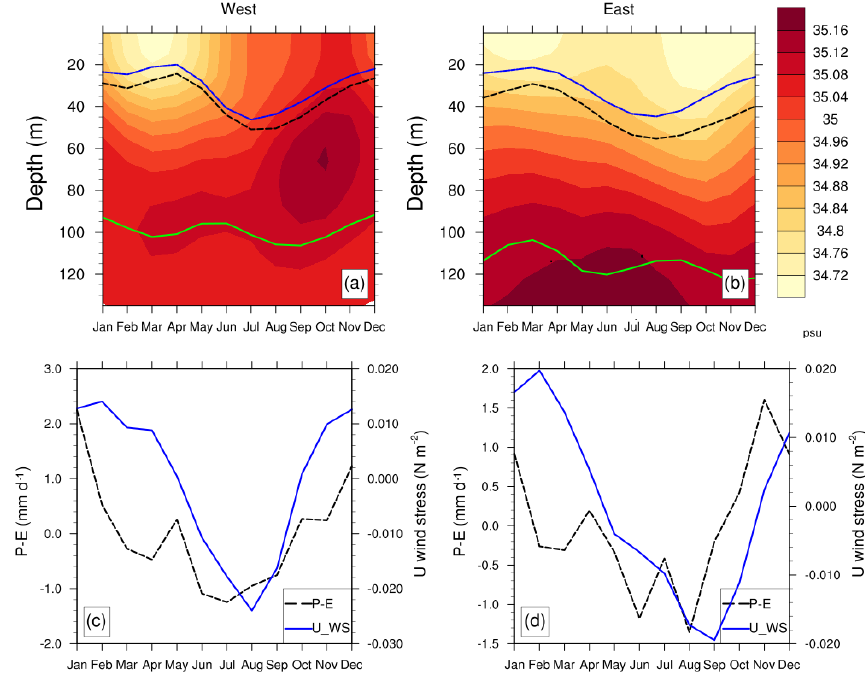
Figure 8. Seasonal variation in the western TIO (12 ◦ S–5 ◦ N, 55–75 ◦ E) (a, c) and the eastern TIO (12 ◦ S–5 ◦ N, 85–100 ◦ E) (b, d) . The top figures show the depth–time plots of the upper-ocean salinity (shaded), the thermocline depth (green line), isothermal layer (dashed black line), and mixed layer (blue line). The bottom figures show the freshwater flux ( P − E ) and zonal component of the wind stress (U_WS) anomalies in the corresponding